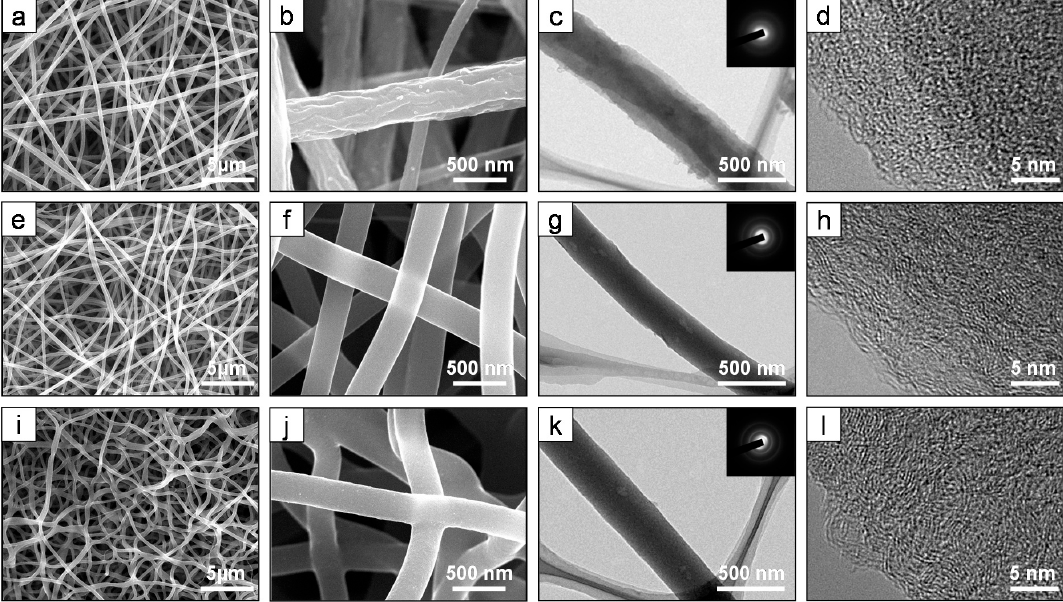
Figure 1. Electron microscope images of carbon nanofibers (CNF) 1000, CNF 1200 and CNF 1400. ( a , b ) SEM and TEM images of ( a – d ) CNF 1000, ( e – h ) CNF 1200, and ( i – l ) CNF